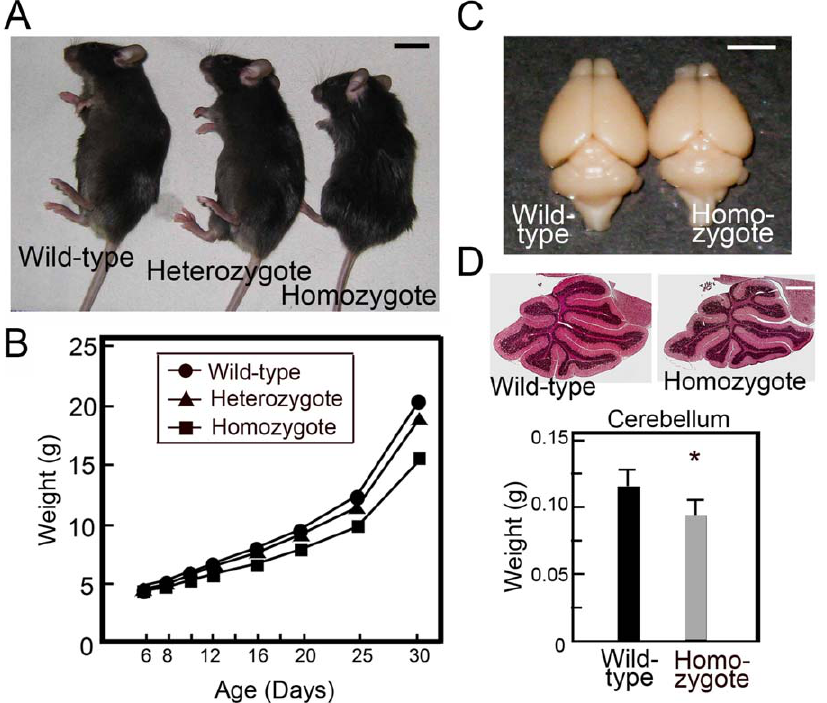
Figure 1. Abnormal cerebellum development of Cadm1 KO. (A) Wild-type, heterozygote, and homozygous Cadm1 KO mice. (P50) (B) The difference in mean weight between homozygous Cadm1 KO mice and their wild-type littermates (five each) was significant at P10 and increased over the next 20 days (A, B); at P30, the mean weight of the homozygous Cadm1 KO mice was 20–25% less than that of the wild-type mice. In addition, the brains of homozygous Cadm1 KO mice were smaller (C, n=22), and the cerebellums of homozygous Cadm1 KO mice had an approximately 20% reduction in size and weight (D, n=10). Bars in the graph indicate mean 6 standard error (SEM). Student’s t -test (* p , 0.05). Bars in the pictures indicate 1 cm (A), 5 mm (C), and 0.75 mm (D),